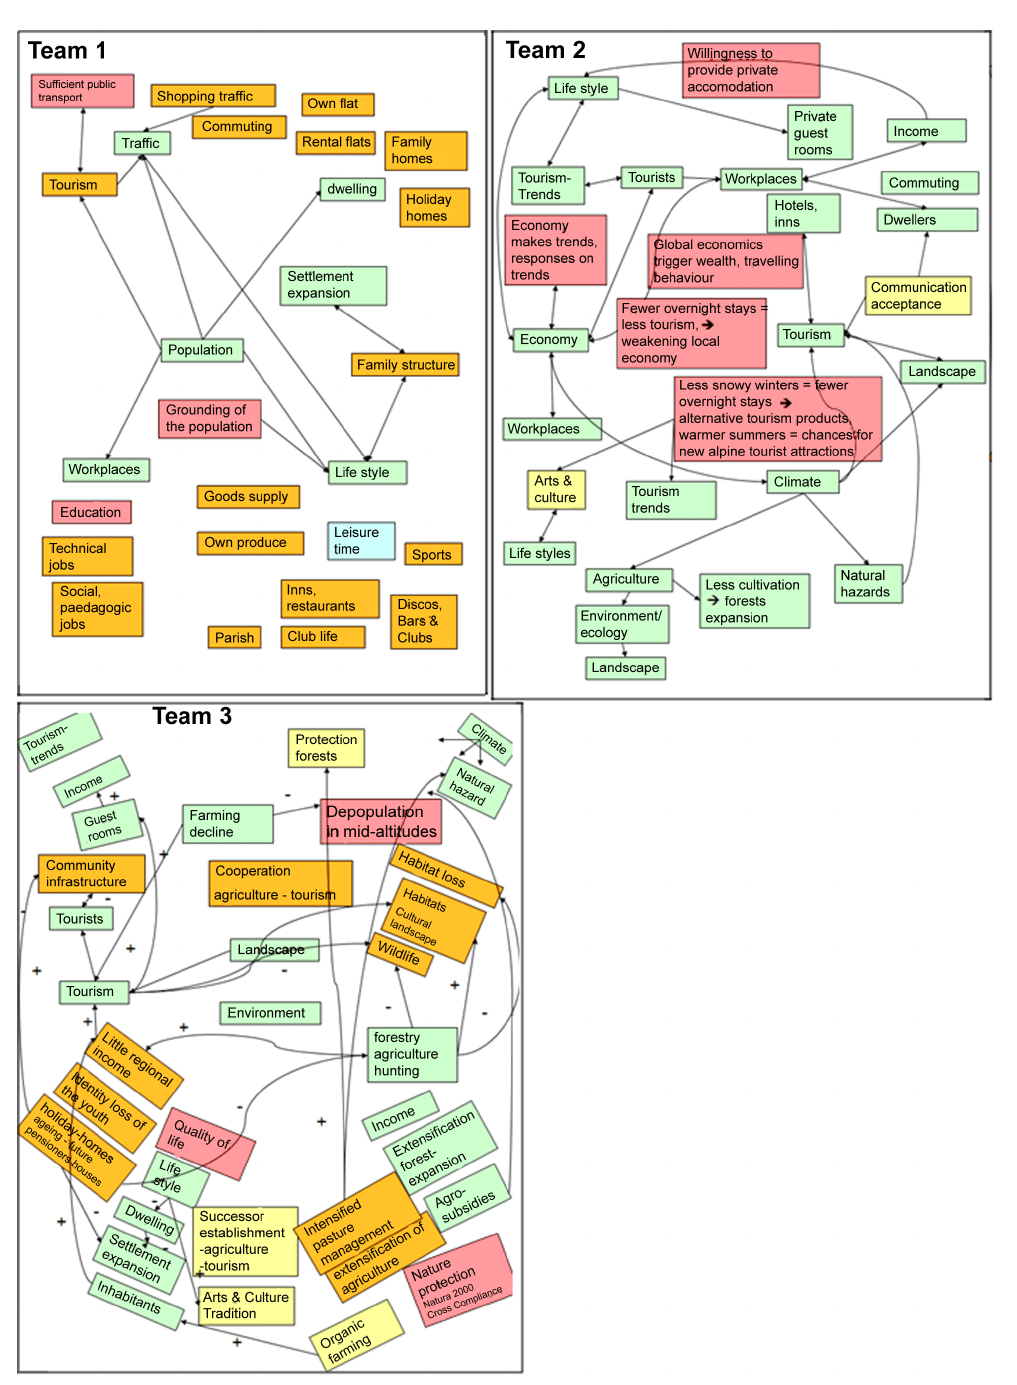
Fig. 1 . The causal loop diagrams indicate clearly the different emphasis of the three teams “Economy and Tourism”, “Society and Settlement” and “Environment and Landscape”. Green keyword cards were prepared, additional colored cards were added with text prepared by the participant teams. Team one used red cards to represent important issues and orange cards to add more information. Team two selected red cards to emphasize the main cause-effect chains. Team three added red cards to group the green cards and included orange and beige cards for additional